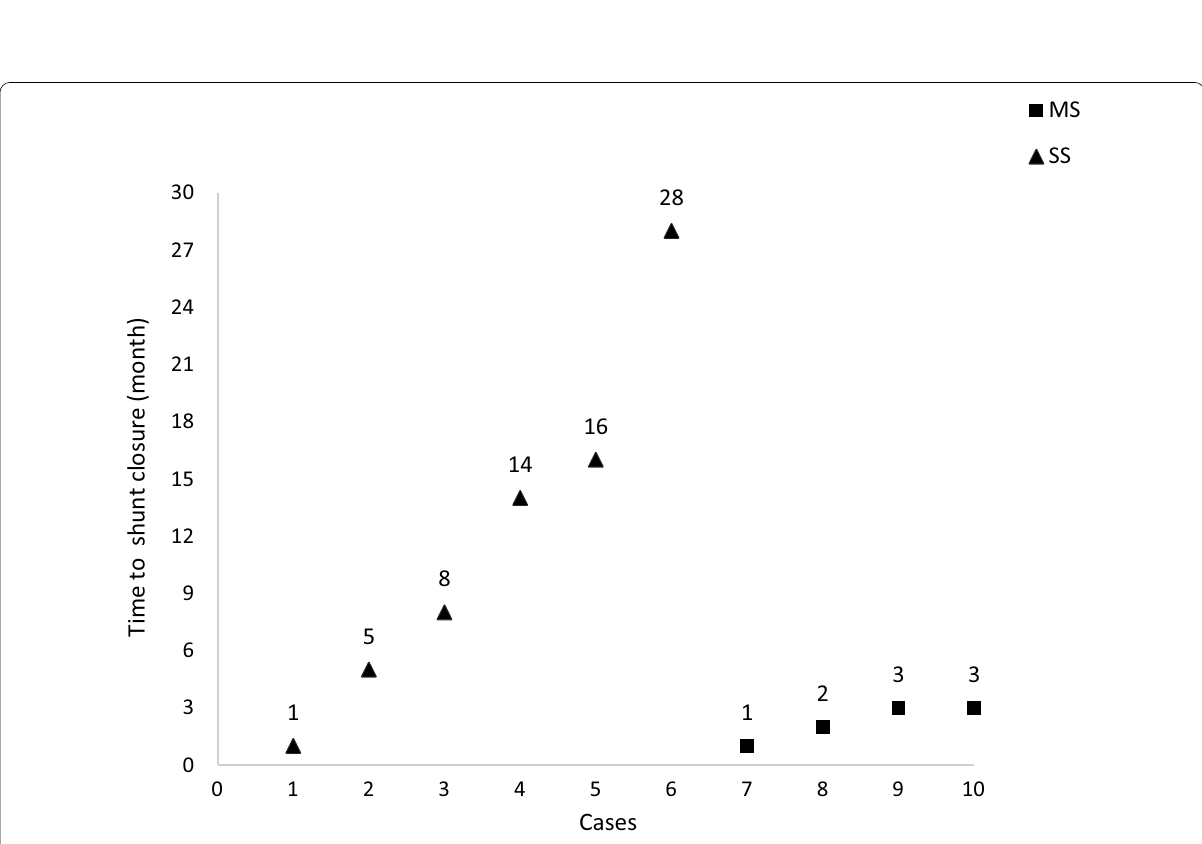
Fig. 3 Spontaneous closure of shunts occurred in ten conservatively treated children, including six cases in the single-shunt group and four cases in the multiple-shunt group. SS: single shunt; MS: multiple